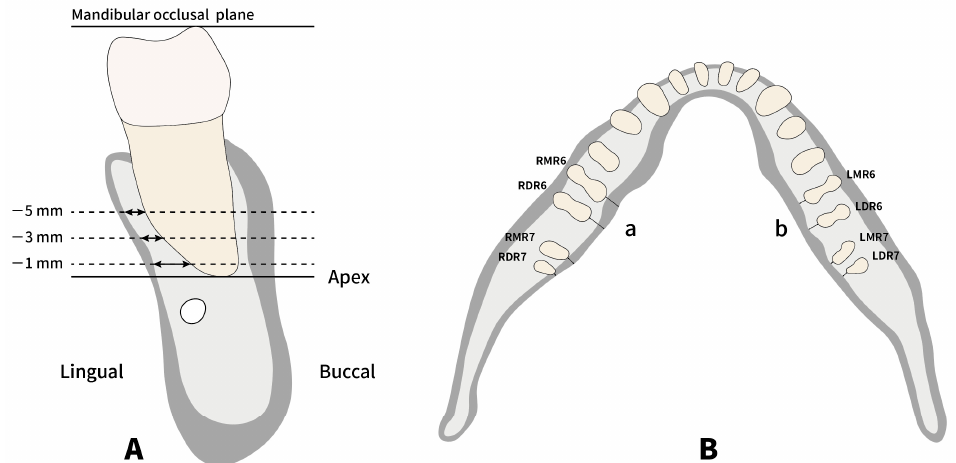
Figure 3. ( A ) The distance between the root and the lingual cortical bone was measured in a plane parallel to the mandibular occlusal plane and 1, 3, and 5 mm away from the apex. ( B ) Schematic diagram showing the distance measured between the root and lingual cortical bone on the axial plane. (a) distance between molar roots and outer lingual cortical bone, (b) distance between molar roots and inner lingual cortical